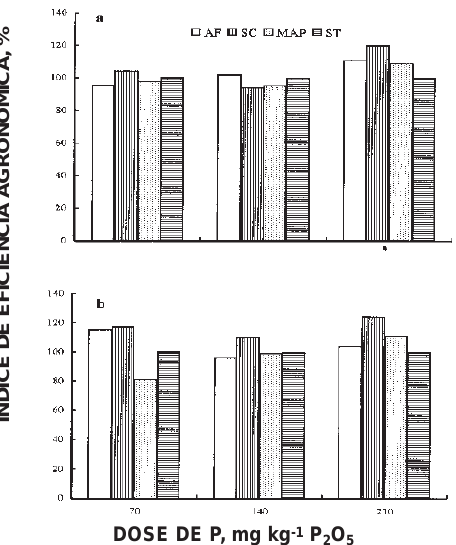
Figura 3. Índices de eficiência agronômica relativos aos dados de produção de matéria seca obtidos nos latossolos vermelho-amarelos, unidades Itororó (a) e Três Barras (b) (AF: ácido fosfórico; SC: suspen- são coloidal 10-30-00; MAP: fosfato monoamônico, e ST: superfosfato